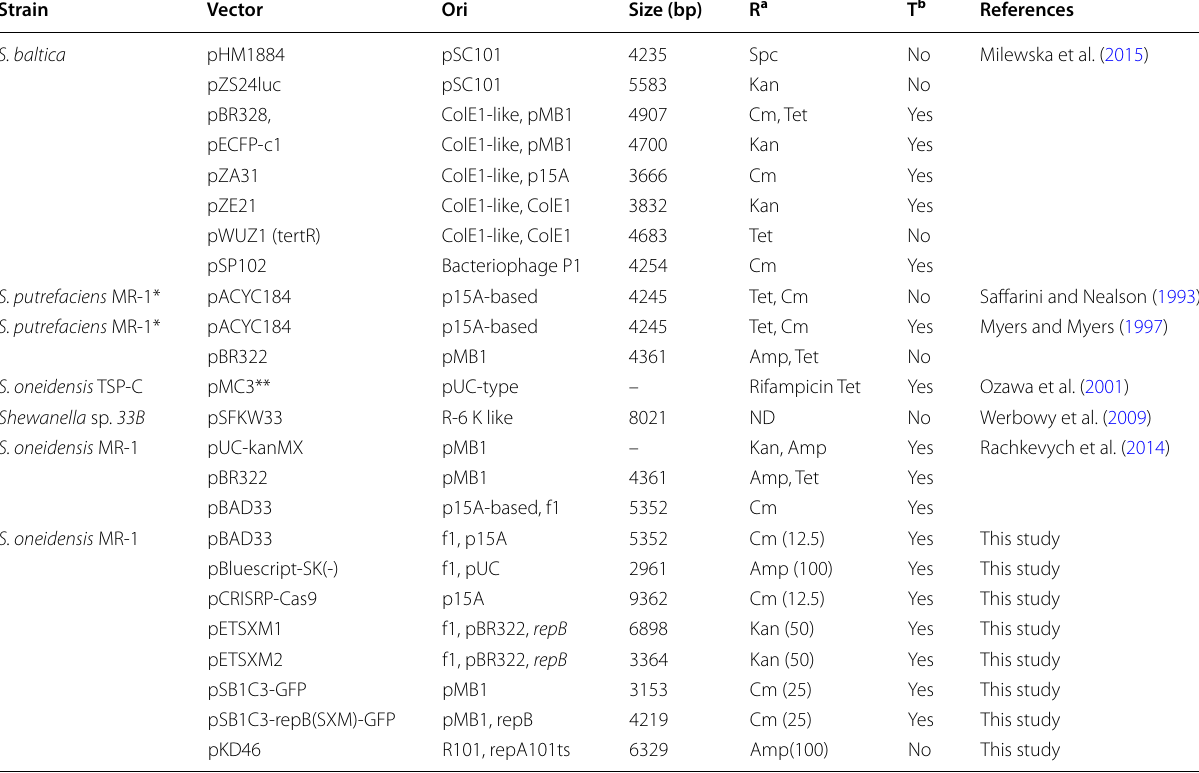
Table 1 Transformation of Shewanella species with vectors contained a diverse array of origin, size and antibiotic resistance